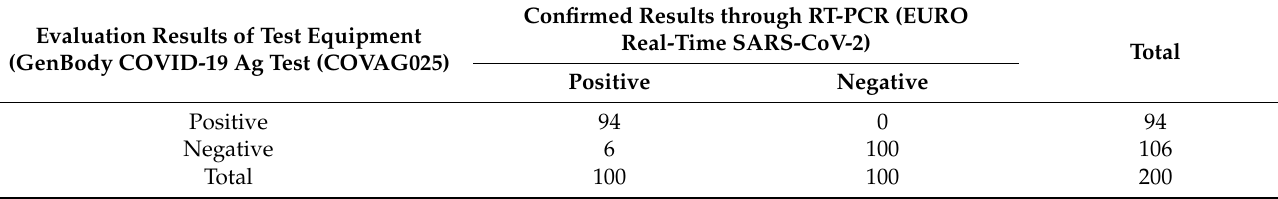
Table 4. Results of the prospective study using the GenBody COVID-19 Ag test (COVAG025). Evaluation Results of Test Equipment (GenBody COVID-19 Ag Test (COVAG025)